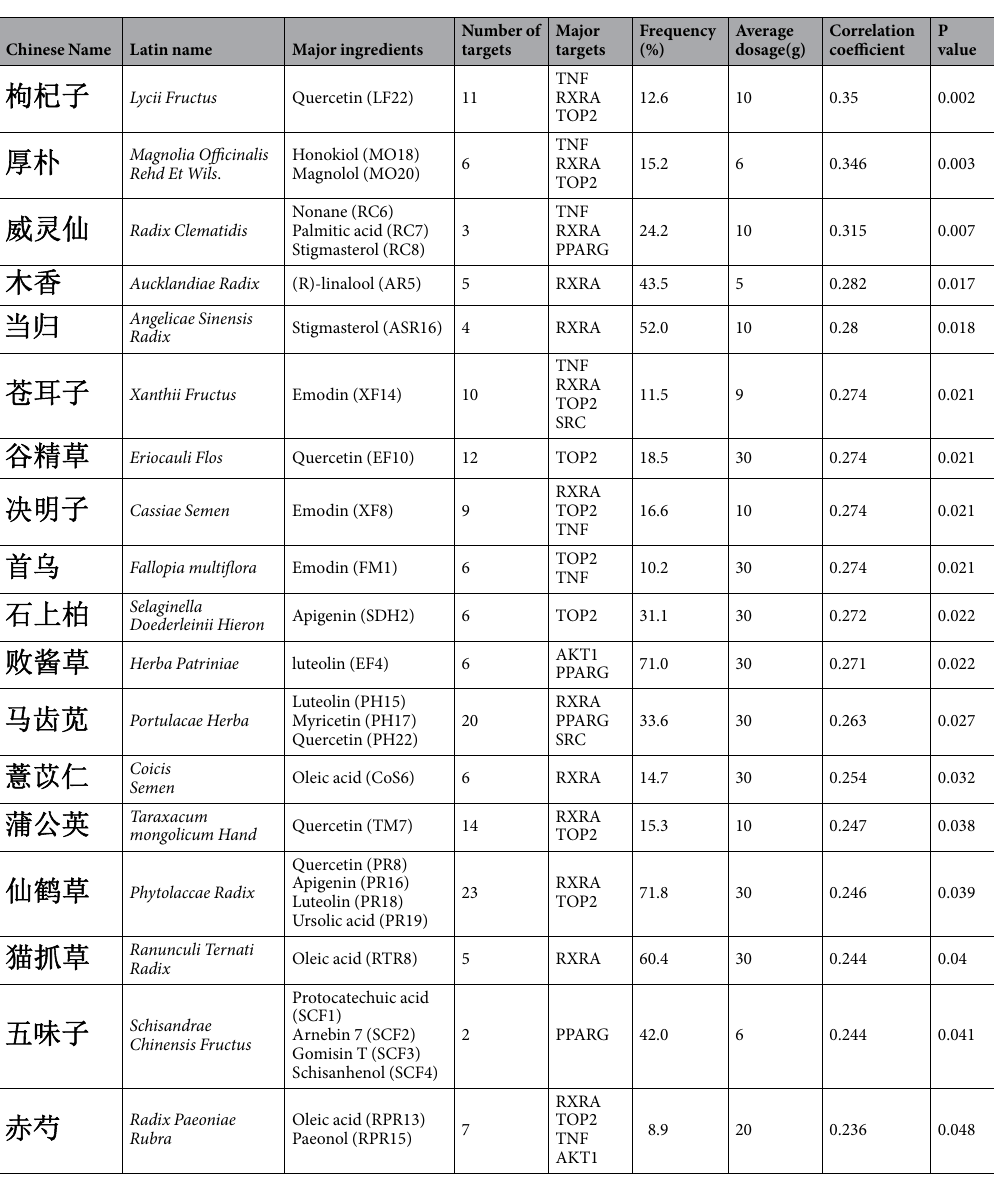
Table 2. The major ingredients and major targets of the 18 herbs involved in CRC